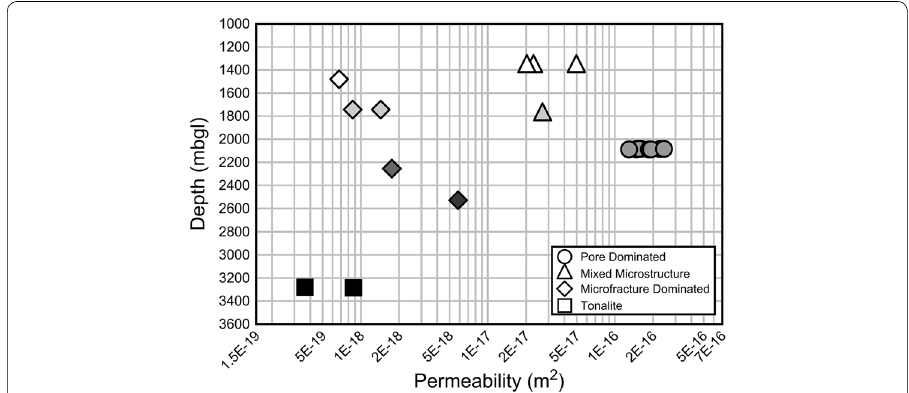
Fig. 12 Depth versus Permeability corrected for lithostatic pressure with lithologies identified. Tone darkens with depth of sample, as shown in legend in Fig.